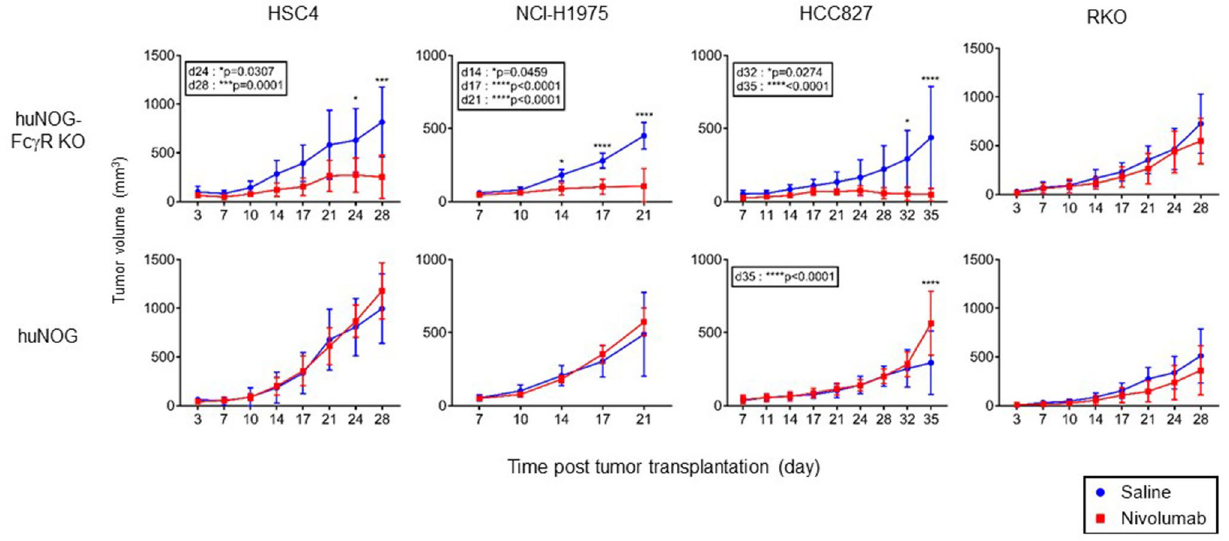
Figure 3. Nivolumab-induced tumor suppression in huNOG-FcγR −/− mice. HSC4, HCC827, NCI-H1975, and RKO cells were subcutaneously inoculated in the flank of huNOG or huNOG-FcγR −/− mice at 12–14 wpt. When the tumor became palpable, 200 μg nivolumab (red line) or saline (blue line) was administered by intraperitoneal (i.p.) injection once a week for 3–4 weeks. The average tumor volume is plotted with SD; the numbers of mice are as follows. For HSC4 and RKO, huNOG mice (n = 5 or 5 for saline- or nivolumab-treated mice, respectively) and huNOG-FcγR −/− mice (n = 4 or 5 for saline- or nivolumab-treated mice, respectively). For NCI-H1975, huNOG mice (n = 5 or 5 for saline- or nivolumab-treated mice, respectively) and huNOG- FcγR −/− mice (n = 5 or 4 for saline- or nivolumab-treated mice, respectively). For HCC827, huNOG mice (n = 5 or 5 for saline- or nivolumab-treated mice, respectively) and huNOG-FcγR −/− mice (n = 4 or 4 for saline- or nivolumab-treated mice, respectively). More than three independent experiments were repeated for each tumor cell line and representative data were shown. Asterisks indicate statistical significance by a repeated measure ANOVA with Sidak’s multiple comparison test. The p-values are indicated in the inset (*p < 0.05, **p < 0.01, ***p < 0.001, ****p < suppression, some of the nivolumab-treated huNOG-FcγR −/− mice had an elevated number of human CD3 + T cells in the tumor compared to control saline-treated huNOG-FcγR −/− mice (Fig. 6). The proportion of CD4 + and CD8 + T cells was not different between nivolumab-treated mice and control saline-treated mice except for HSC4-bearing huNOG mice, which showed an increase or decrease of CD4 + or CD8 + T cells, respectively (Supplementary Fig. 7). Human NK cells were not detected in tumor infiltrating human immune cells by flow cytometry (Supple- mentary Fig. 9a). The proportion of human monocytes/macrophages was 1 or 5% of human CD8 + T cells in nivolumab-treated huNOG-FcγR −/− mice with HSC4 or NCI-H1975, respectively (Supplementary Fig. 9b). These results indicate that T cells are mainly responsible for the tumor rejection. The proportion of T-cell subsets was significantly altered by nivolumab treatment both in huNOG-FcγR −/− and huNOG mice. Although the ways are not the same in different tumor cell lines, an increase of CD4 + effector memory T cell (T EM ) population in the PB and spleen was common in huNOG-FcγR −/− mice (Fig. 7, Supple- mentary Figs. 10, 11). Accordingly, the size of the CD4 + T n population decreased in huNOG-FcγR −/− mice with NCI-H1975 and RKO cells and a similar tendency in mice with HSC4 and HCC827 cells. In huNOG mice, the increase in CD4 + T EM was not detected. Rather, an opposite increase of CD4 + T n was detected in the PB of HSC4- bearing mice and the spleen of NCI-H1975-bearing mice (Fig. 7). Similar changes were also detected in CD8 + T cells. In all of the tumor cell lines, nivolumab induced a decrease of CD8 + T n and an increase of activated CD8 + T cells in either PB or spleen, or both in huNOG-FcγR −/− mice, T EM for HSC4, NCI-H1975, and RKO or T CM for HCC827 (Fig. 8, Supplementary Figs. 12, 13). On the other hand, nivolumab treatment resulted in an increase of CD8 + T n population in the PB and spleen of HSC4-bearing huNOG and in the spleen of NCI-H1975-bearing huNOG mice (Fig. 8). The concomitant decrease of the CD8 + T EM population was induced in HSC4-bearing huNOG mice (Fig. 8). In TILs, most of the CD4 + and CD8 + T cells had activated phenotypes, and few were naïve T cells in both huNOG-FcγR −/− and huNOG mice prior to nivolumab treatment. The alternations of the composition of CD4 + T cell subsets were detected in NCI-H1975- and RKO-bearing huNOG-FcγR −/− mice, namely, a decrease in T CM and increase in T EM . No changes in CD4 + TIL subsets were detected in huNOG mice after nivolumab treatment (Fig. 7). Regarding CD8 + TILs in huNOG-FcγR −/− mice, there were no evident changes except an increase of T EM in RKO-bearing huNOG-FcγR −/− mice (Fig. 8). Interestingly, HSC4- or HCC827-bearing huNOG mice showed a decrease of T EM and increase of terminally differentiated effector-memory T cells (T DEM ) (Fig. 8).